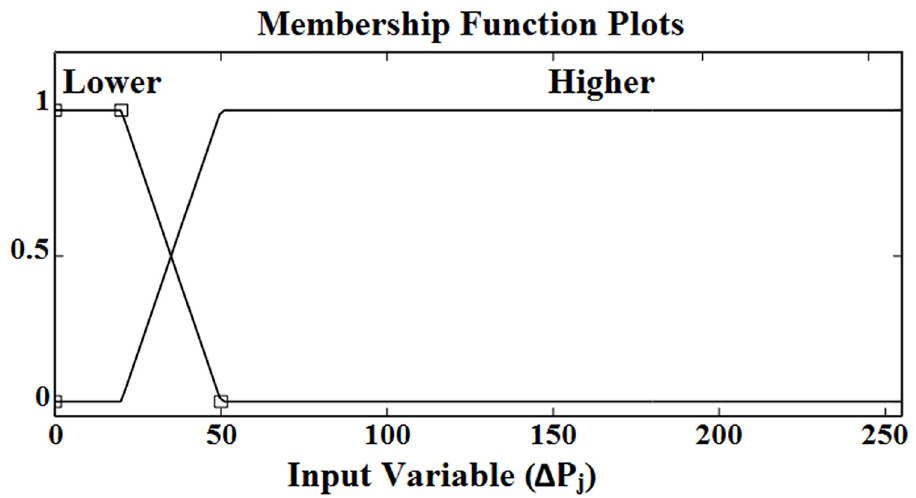
Fig 5. MFs of the input variable Δ P j .